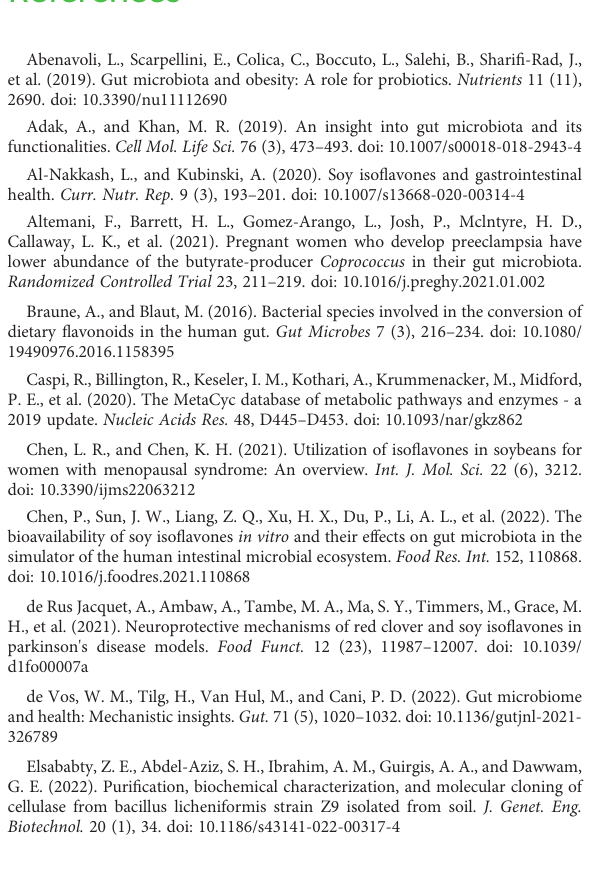
SUPPLEMENTARY FIGURE 1 The total ion chromatogram (TIC). (A) Mix standards; (B) Samples; (C) The overlap chromatogram of qualitiy control and sample. SUPPLEMENTARY FIGURE 2 Quality assessment and control of short-chain fatty acids data using principal component analysis (PCA). (A) The score plot of the normal group; (B) The score plot of the soybean iso fl avones group. The point falling outside the ellipse suggests that it may be an outlier. SUPPLEMENTARY FIGURE 3 Data standardization of short-chain fatty acids. (A) Content distribution of each short-chain fatty acid before and after standardization. (B) Content distribution of each sample before and after standardization. SUPPLEMENTARY TABLE 1 The methodological investigation of GC-MS. SUPPLEMENTARY TABLE 2 The numbers of demultiplexed and feature sequences in each